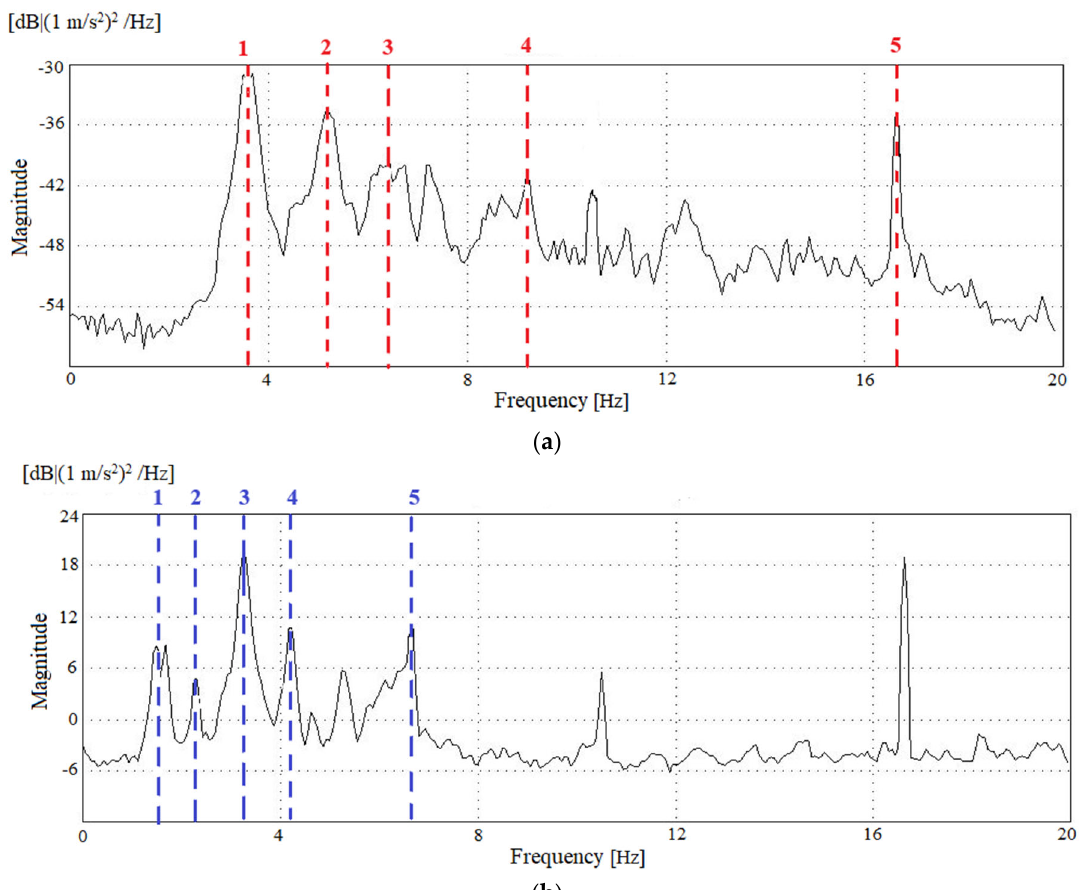
Figure 8. EFDD method—average normalized singular values of the spectral matrices: ( a ) unloaded configuration, ( b ) loaded configuration.